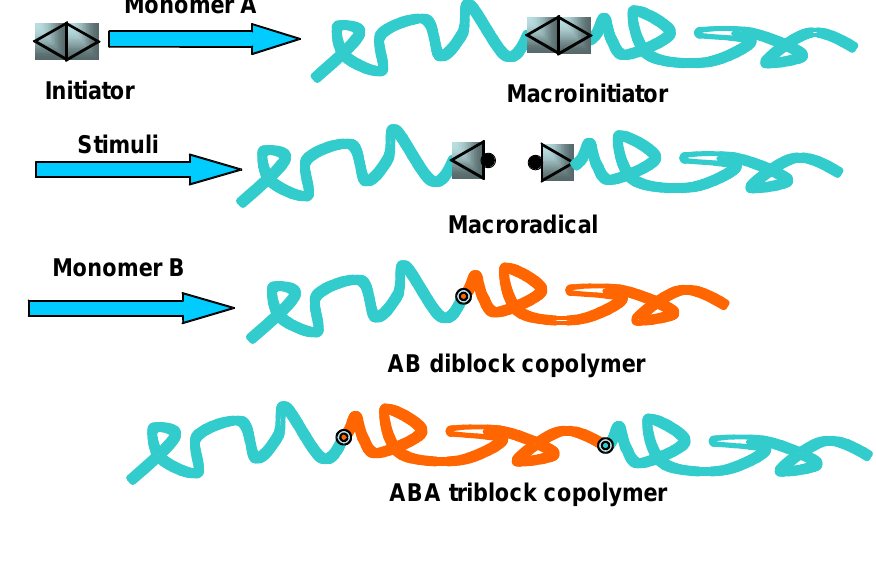
Figure 5. Scheme of PRBCs prepared from a special